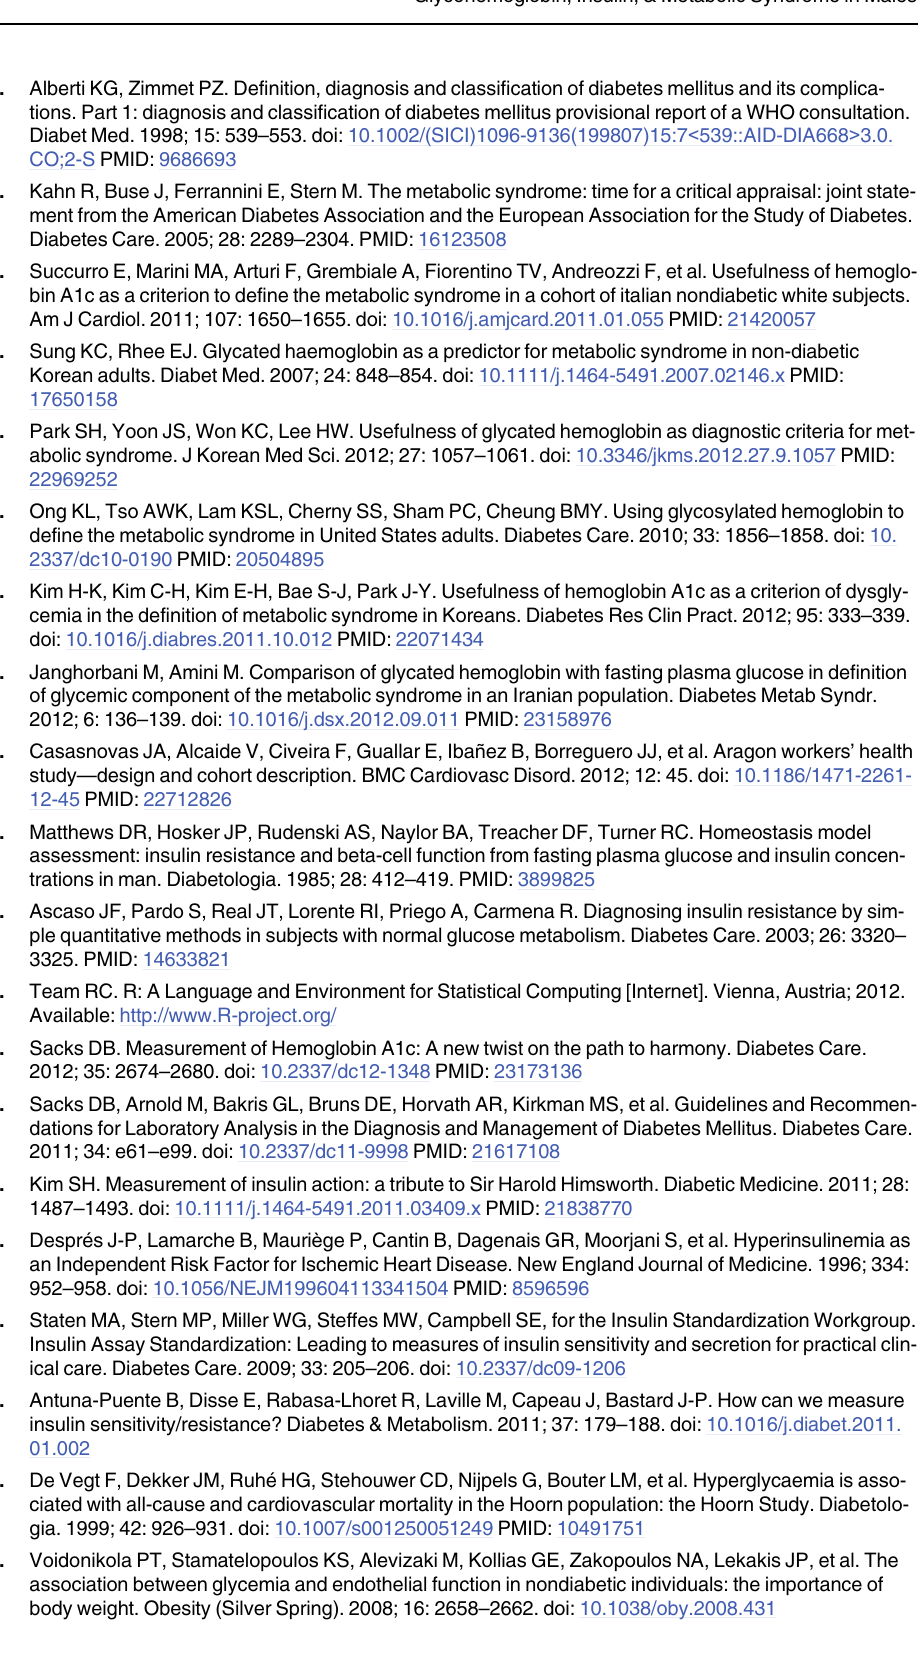
PLOS ONE | DOI:10.1371/journal.pone.0132244 August 4,